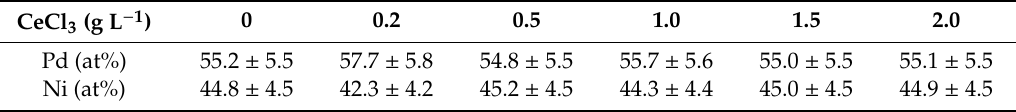
Table 2. EDS results for the Pd-Ni alloy film that was electroplated in a solution that contained different concentrations of CeCl 3 .